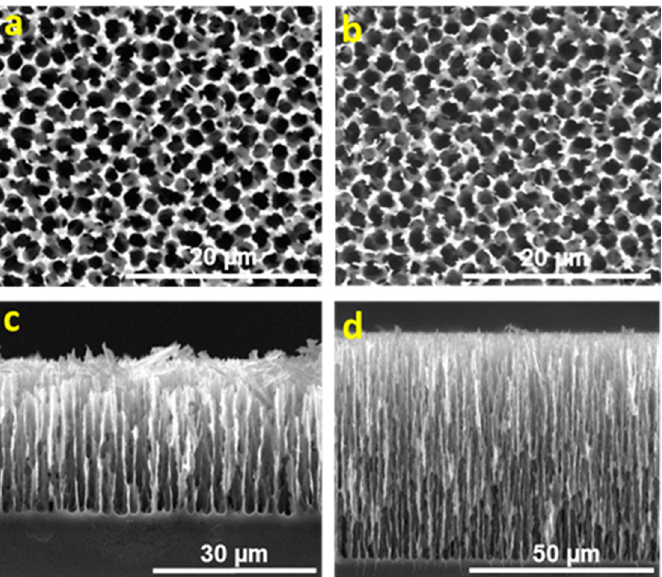
Figure 1. Environmental scanning electron microscopy (ESEM) image of a top and cross-sectional view of macroporous silicon (MacroPSi) substrates with 6.2 Ω cm resistivity: ( a , c ) MacroPSi-1: HF:DMF = 1:3, current density = 10 mA/cm 2 , etching time = 90 min and porosity = 74.9 ± 6.5%; ( b , d ) MacroPSi-2: HF:DMF = 1:3, current density = 20 mA/cm 2 , etching time = 90 min and porosity = 86.2 ± 6.2%.